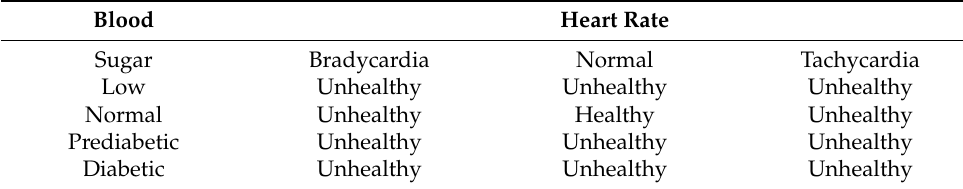
Table 2. Rules for